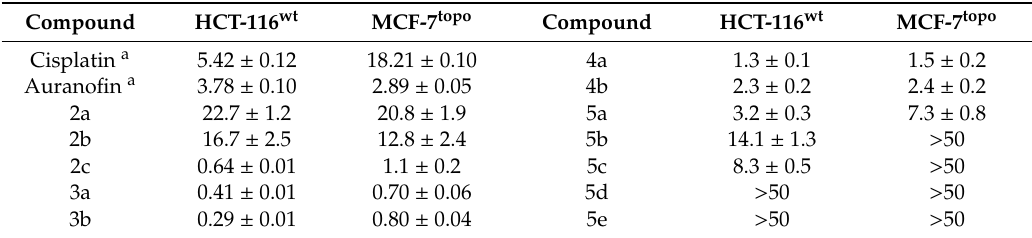
Table 2. IC 50 values ( µ M) of compounds 2a – 5e against HCT-116 wt and MCF-7 topo cells after 72 h of incubation.